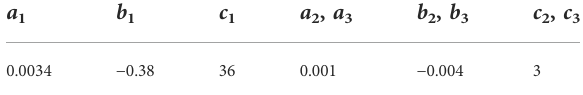
TABLE 2 Parameters of actual carbon emission model.